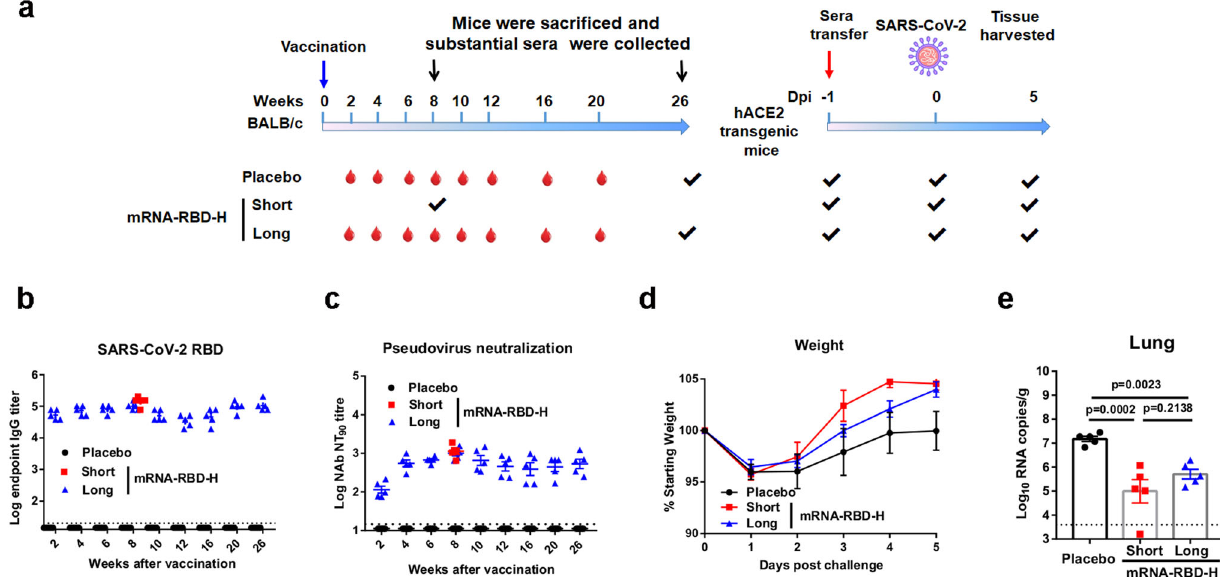
Fig. 4 Duration and long-term protection of humoral response induced by mRNA-RBD. a Passive immunization and challenge schedule. The blue and red arrow indicates the time of vaccination and sera transfer, respectively. b , c Groups of BALB/c mice ( n = 10) received 15 μ g of mRNA-RBD or a placebo. Half of the mice per group were euthanized at 8 weeks (short term) post vaccination, and massive sera were collected for further passive immunization. The other mice of the group were bled as desired and eventually euthanized at 26 weeks (long term) post vaccination to collect massive sera for further passive immunization. All serum samples were detected for IgG ( b ) and neutralizing antibodies ( c ) titers. d – e hACE2 transgenic mice ( n = 5) were administered 350 μ l per mouse of pooled short- and long-term immune sera and one day later were challenged with 1 × 10 5 FFU of SARS-CoV-2 via the i.n. route. d The hACE2 mice weight change was recorded after challenge. e Virus titers in lung. mRNA-RBD-H indicates the high-dose vaccine (15 μ g). Data are means ± SEM (standard error of the mean). Comparisons were performed by Student ’ s t -test (unpaired, two tailed). Placebo animals = black circles; animals for long-term study = blue triangles; animals for short-term study = red squares; dotted line = the limit of detection. Data are one representative result of two independent experiments. Source data are provided as a Source Data fi